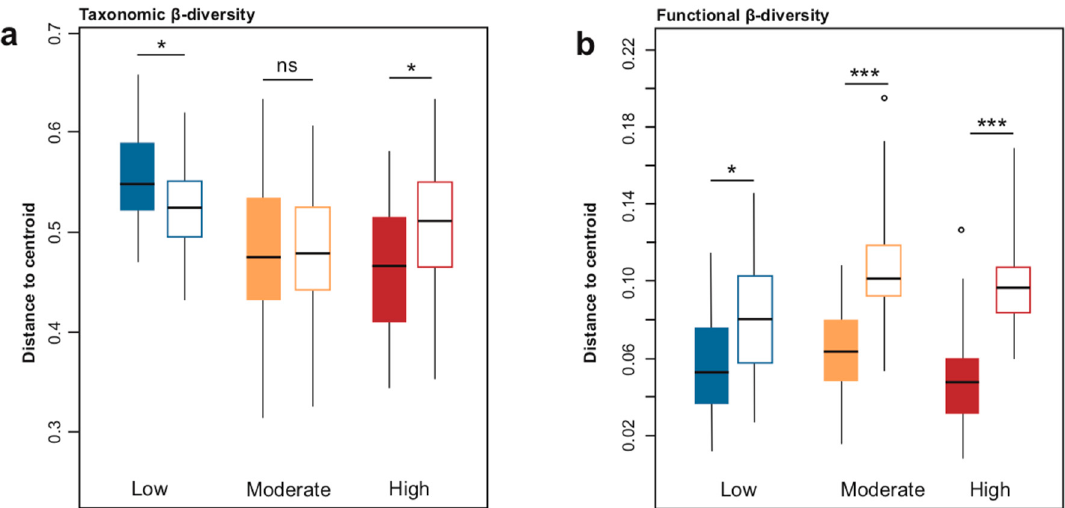
Figure 5. Differences in taxonomic ( a ) and functional ( b ) β -diversity induced by non-native species in three groups of degradation level. Variations in β -diversity were assessed by comparing the distances of sites to centroids of native species (native plant species that recorded in all sampling plots) to those of the total flora (complete plant species that are recorded in all sampling plots). Notes: the color-filled boxes represent the β -diversity of total species, and the color-outlined boxes represent the β -diversity of native species. Asterisks indicate a significant change in paired sample t-tests that are adjusted by the multiple test Holm correction. Significance levels: * p < 0.05; *** p < 0.001; ns, not significant.